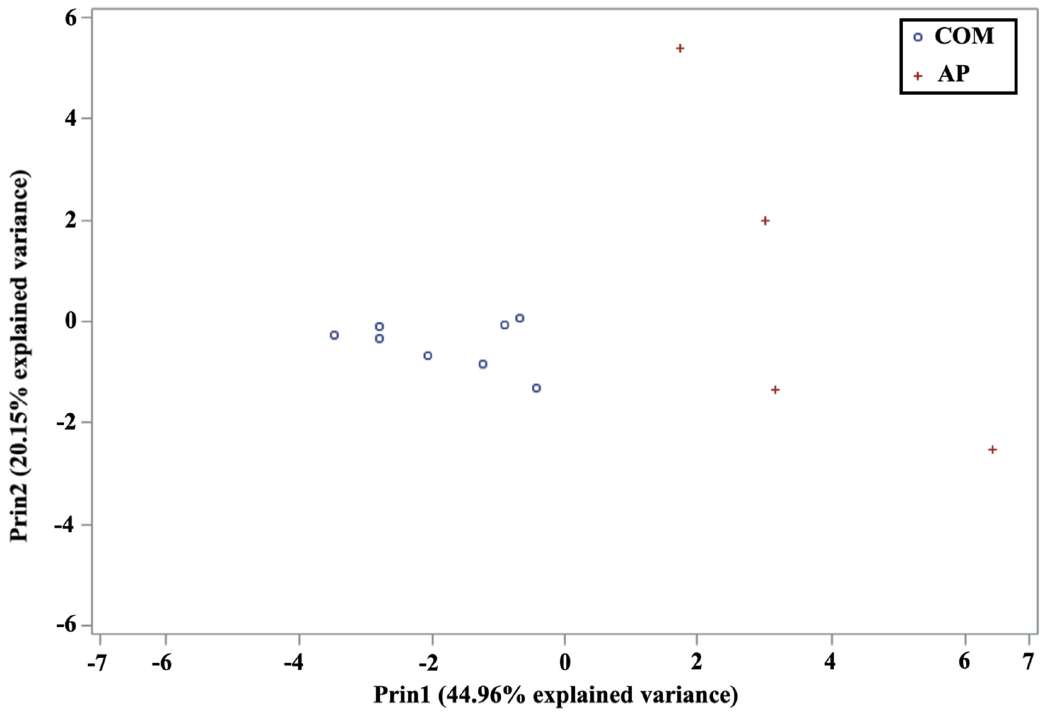
Figure 4. Representation of the bee pollen samples (AP, experimental apiaries; COM, commercial) as function of principal component 1 (Prin1) and 2 (Prin2).